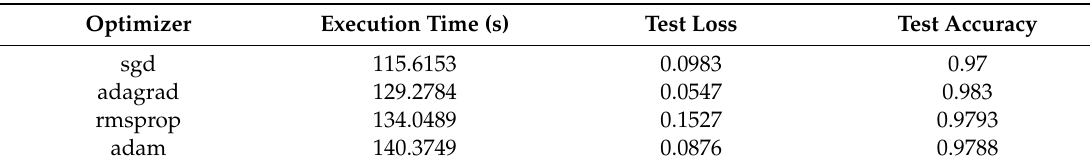
Table 19. E ff ect of adaptive learning rate on multilayer perceptron.